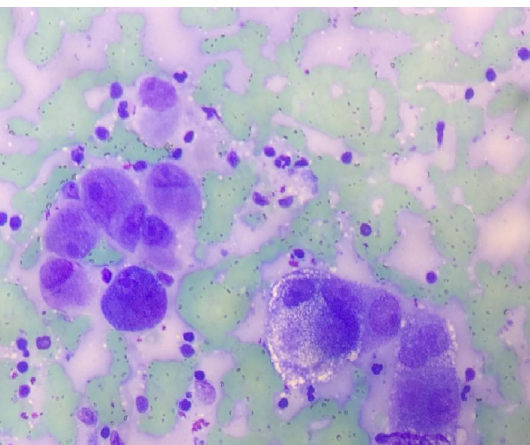
Fig 1: Smear showing metastatic cluster of squamous cell carcinoma.